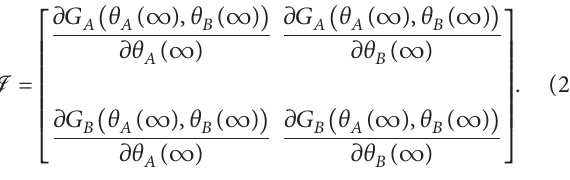
Δ is the determinant of J . τ represents the trace of the matrix J . The main types of fixed points are saddle points, nodal points, and focus points. If Δ < 0, the fixed point is saddle point. If Δ > 0, the nodal point satisfies τ 2 − 4 Δ > 0 and the focus point satisfies τ 2 − 4 Δ < 0. However, if Δ > 0, τ < 0, the fixed point is stable [34]. The physically relevant roots which correspond to the steady state of the system are indicated by red points, and other roots are indicated by blue